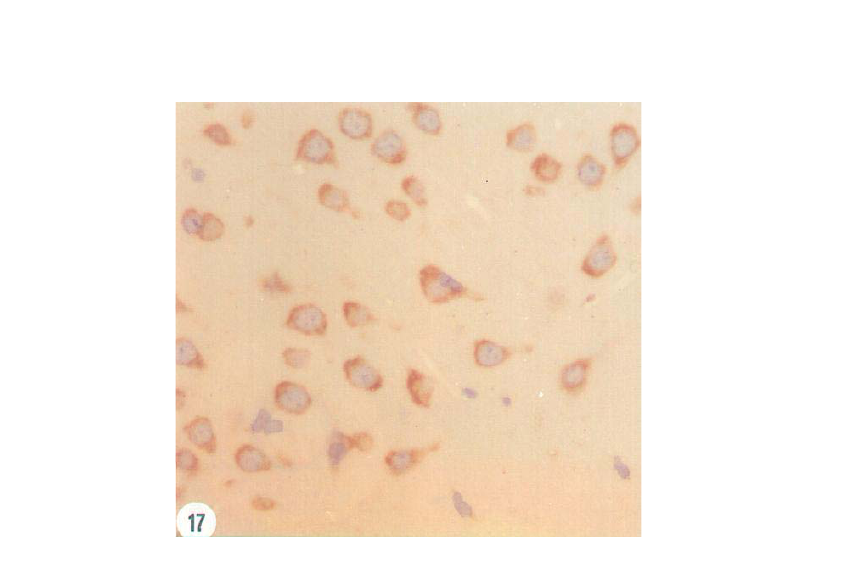
Figure 17. Neurons of cerebral cortex 72 hr after low dose envenoming showing lower Bcl-2 reactivity than that of the previous group. (X400)